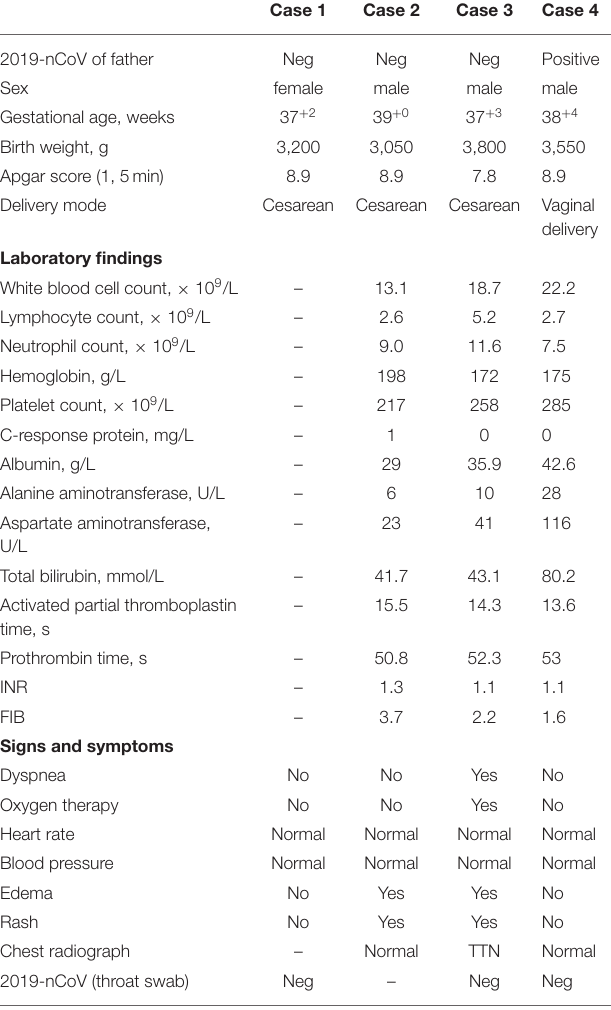
TABLE 2 | Clinic and laboratory characteristics of the